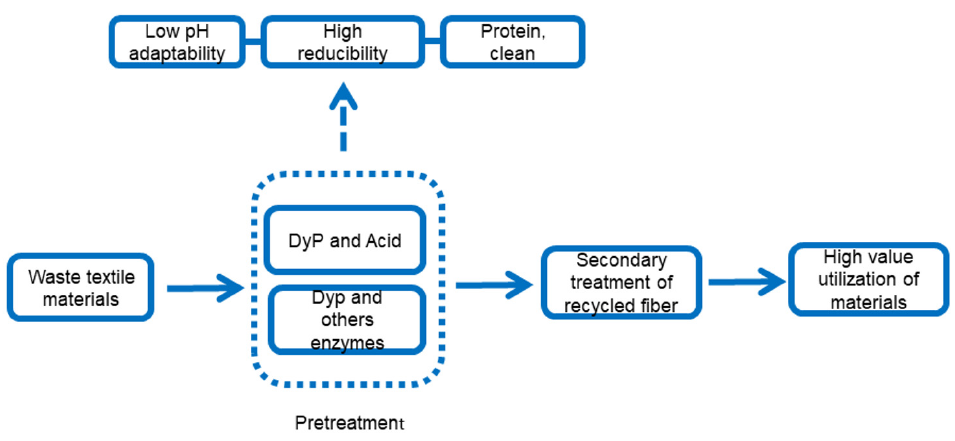
Figure 6. Process graph shows the possible research direction on DyPs regarding dye utilization.